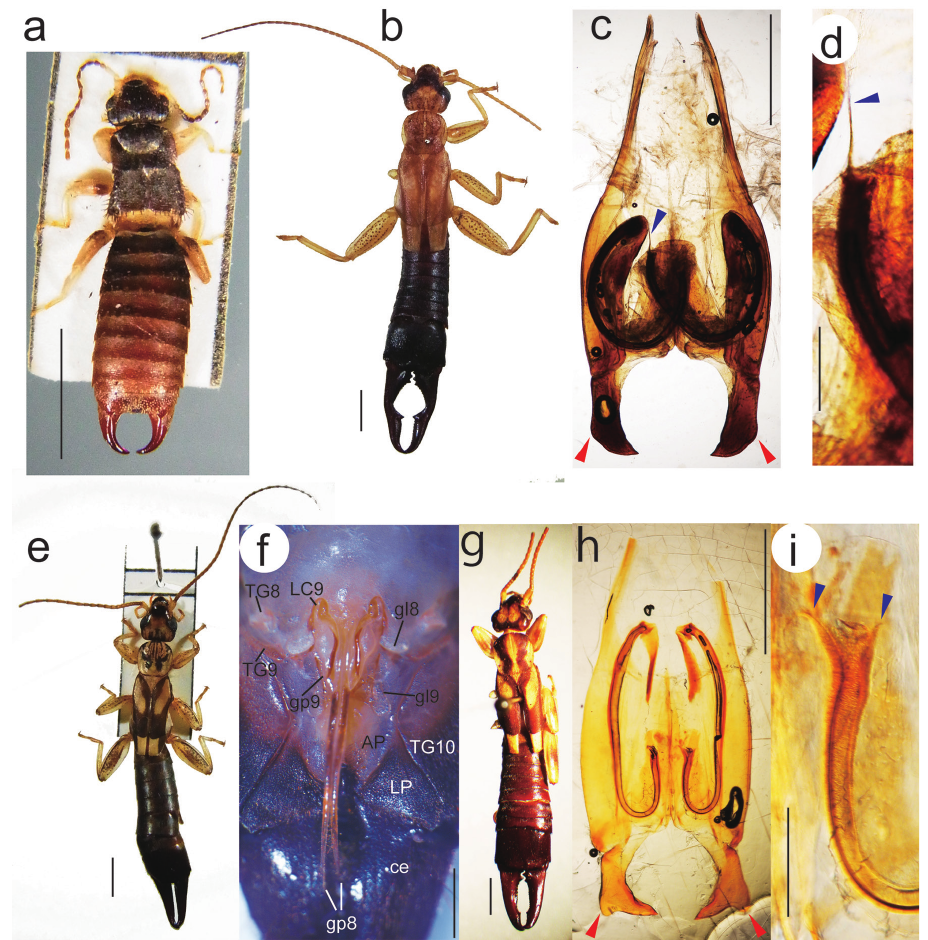
Figure 1. Holotype (male) of Echinosoma roseiventre sp. n. ( a ), a male ( b–d ) and a female ( e–f ) of Cranopygia pallidipennis from Penang Island, and a male of Cranopygia similis from Java (MM No. 3639) ( g–i ). ( a, b, e, g ) habitus; ( c, d, h, i ) male genitalia; ( f ) female genitalic region and ovipositor. The red and blue arrowheads indicate the expanded outer angle of the parameres ( c ) and the distal process of the virgae ( c, d, i ), respectively. Abbreviations: AP, anal plate; ce, cercus (=forceps); gl8, gonoplac (=coxal lobe) VIII ; gl9, gonoplac (=coxal lobe) IX; gp8, gonapophysis VIII; gp9, gonapophysis IX; LC9, latero- coxa IX; LP, lateral plate; TG8–TG10, tergum VIII–X. Scale bars: 3 mm in a, b, e, and g ; 1 mm in c, f and h ; 200 µm in d and i